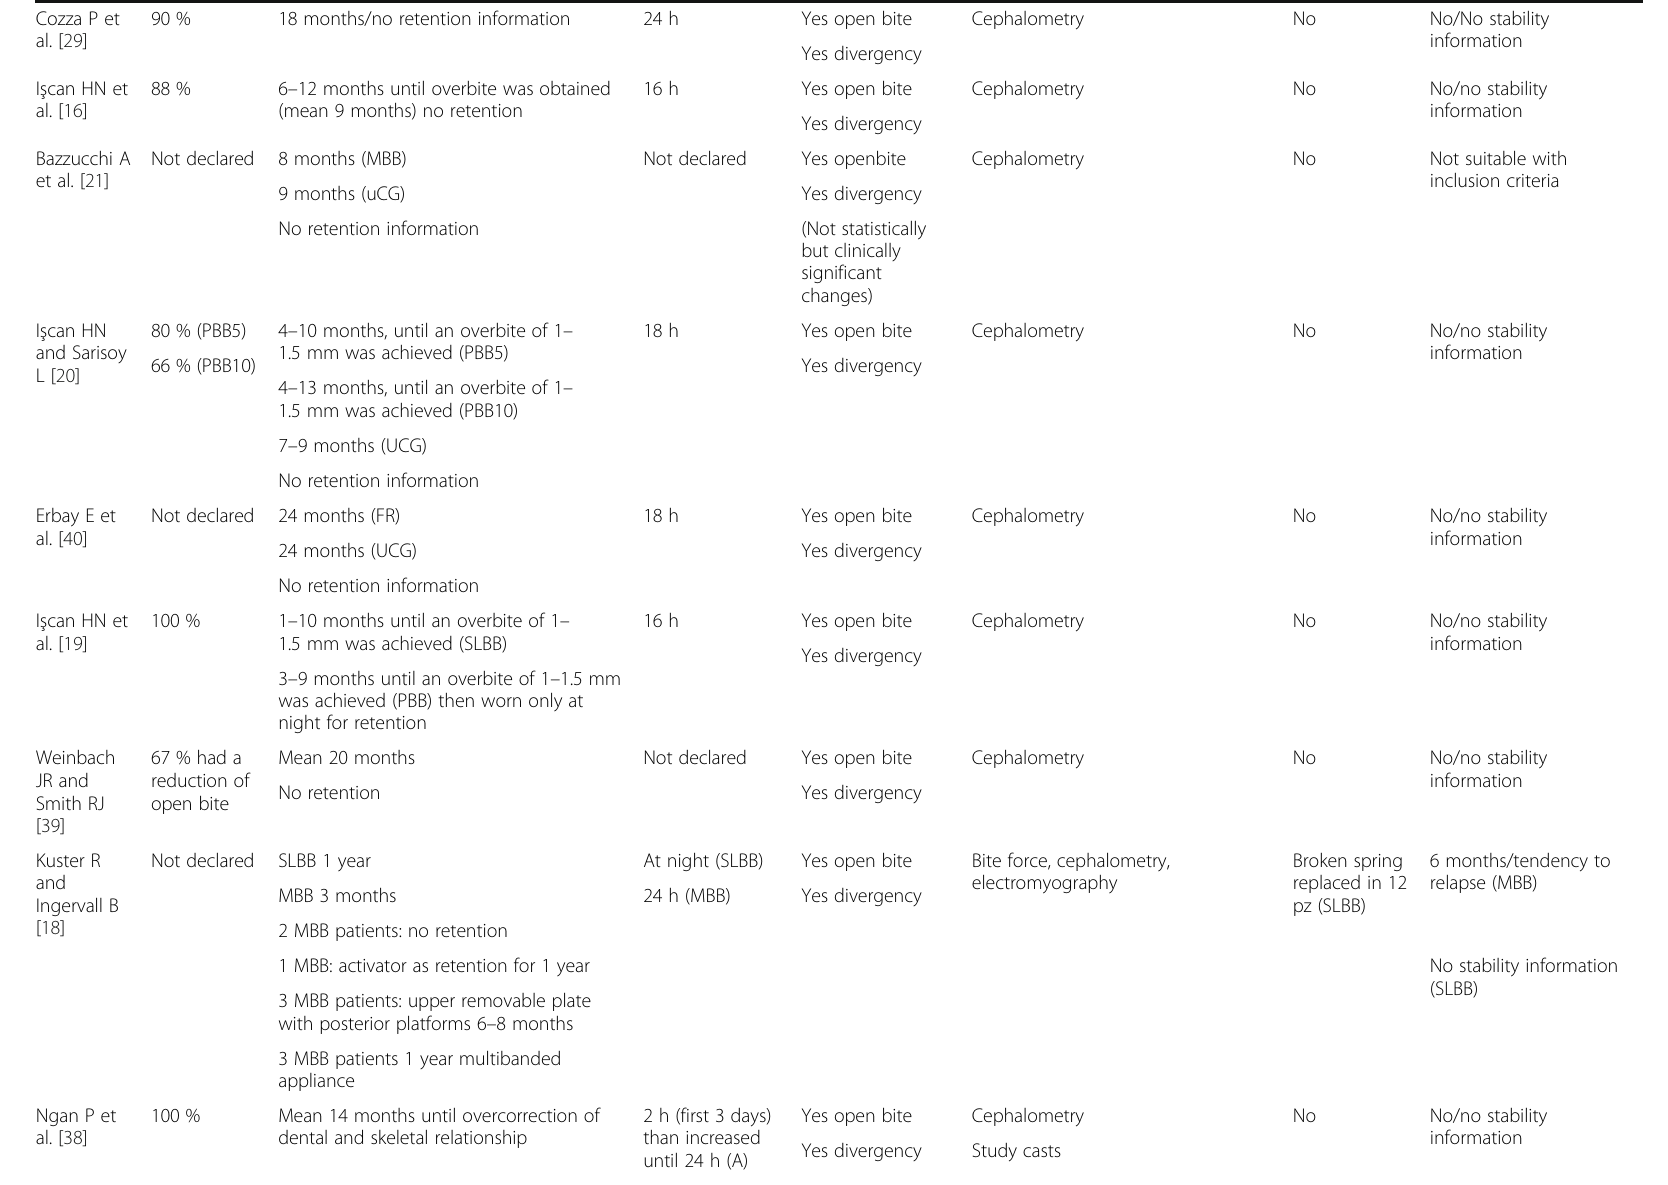
Table 2 Results: success rate, treatment duration, reduction of open bite and divergency, side effects and stability